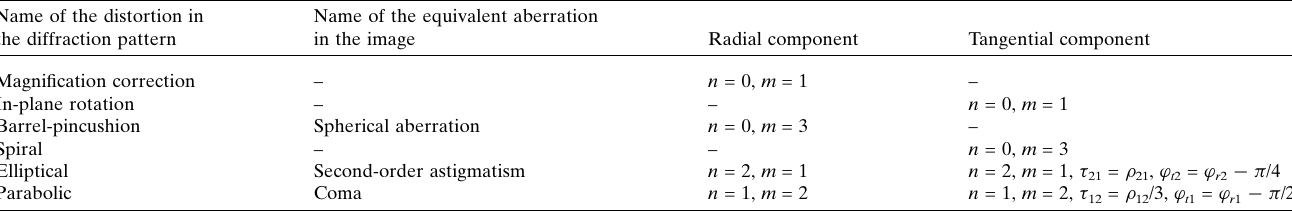
Table 1 Relationship between standard distortions and the coefficients of the general description. Name of the distortion in the diffraction pattern